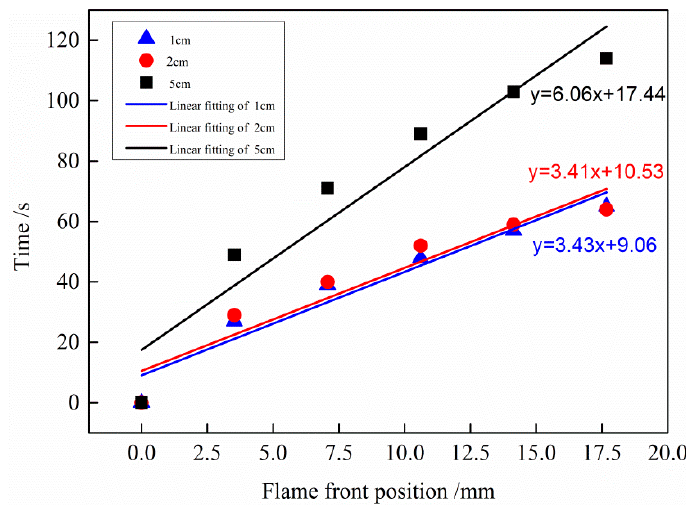
Figure 6. Flame front versus time under the three thickness tests.